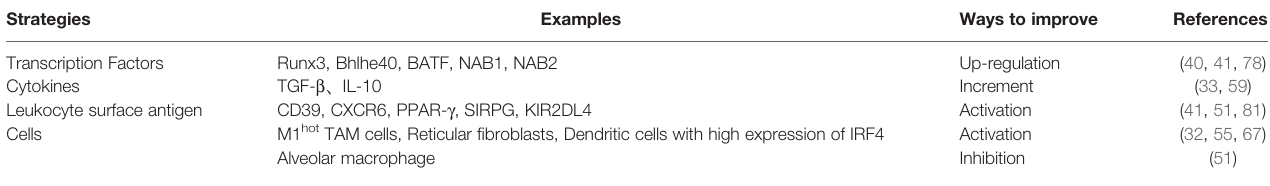
TABLE 3 | Strategies to improve the ef fi cacy of vaccines and adoptive cell therapies by targeting T RM cells. Strategies